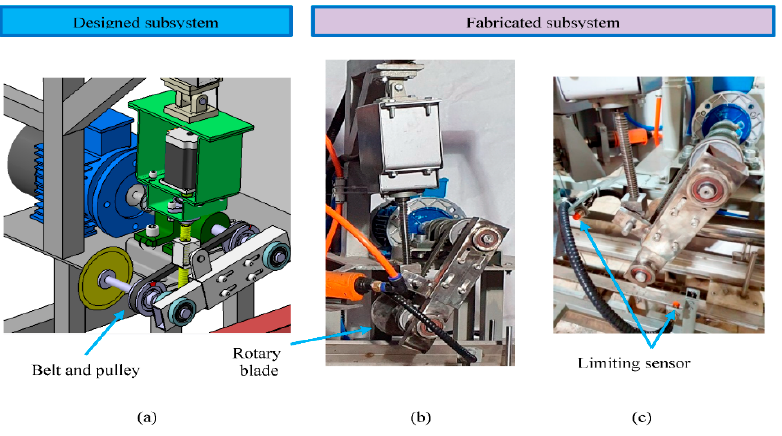
Figure 6. Belly-cutting subsystem: ( a ) designed subsystem, ( b ) fabricated belly-cutting components, and ( c ) limiting sensor.